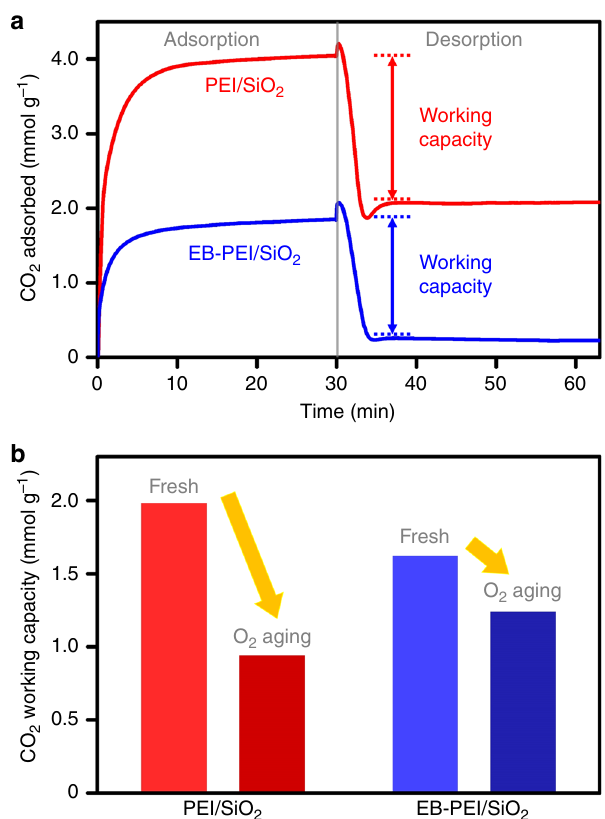
Fig. 2 Comparison of the CO 2 adsorption – desorption behaviours and oxidative stabilities of PEI/SiO 2 and EB-PEI/SiO 2 . a CO 2 adsorption – desorption pro fi les of the fresh adsorbents (adsorption: 15% CO 2 , 10% H 2 O, in N 2 balance at 60 °C; desorption: 100% CO 2 at 110 °C). b CO 2 working capacities before and after the oxidative aging under 3% O 2 in N 2 at 110 °C for 1